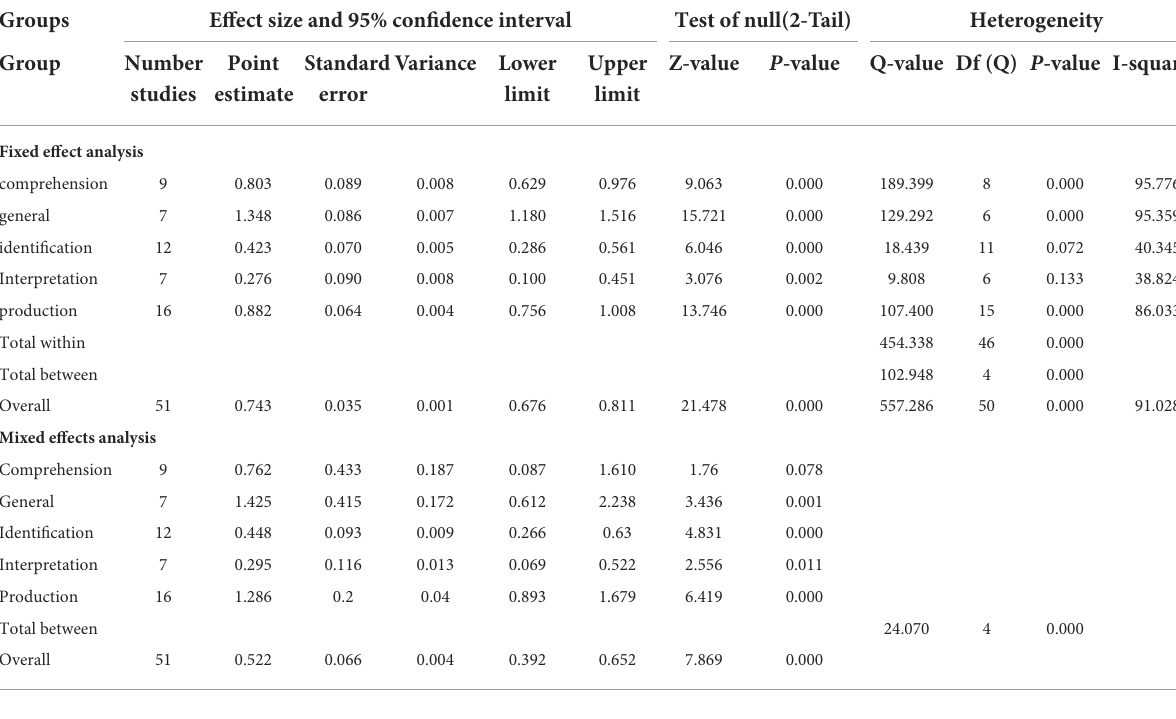
TABLE 4 Moderator analysis of metaphorical competence type.